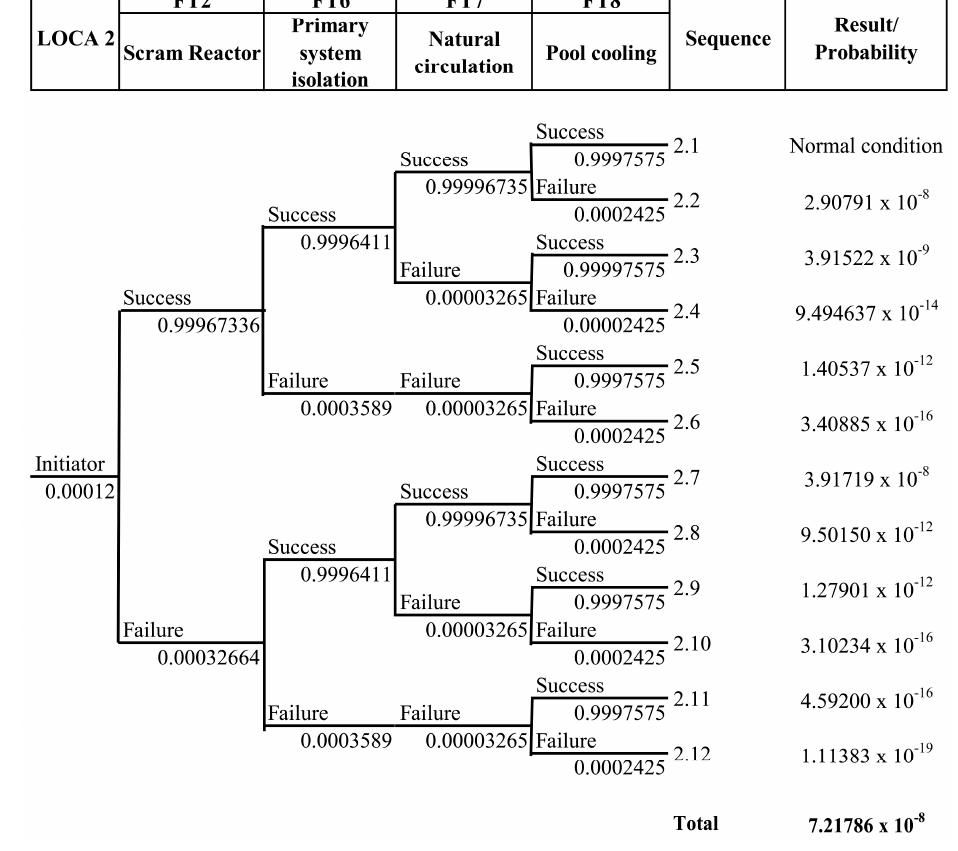
Figure 11. Event tree of LOCA 2.